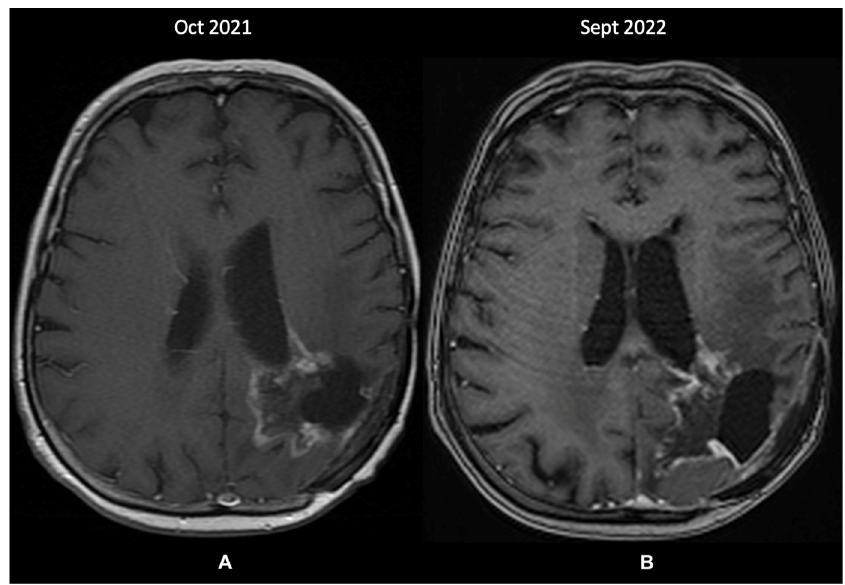
Figure 4. The patient’s last 2 MRI scans, T1 + contrast sequence (October 2021 and September 2022): ( A )—changes within the left parietal lobe suggestive of recurrence and radiation-induced necrosis, extending medially from the postoperative cavity, around the subependymal space adjacent to the posterior horn of the left ventricle; ( B )—discrete changes towards a probable tumor recurrence in the posterior part of the cystic cavity.